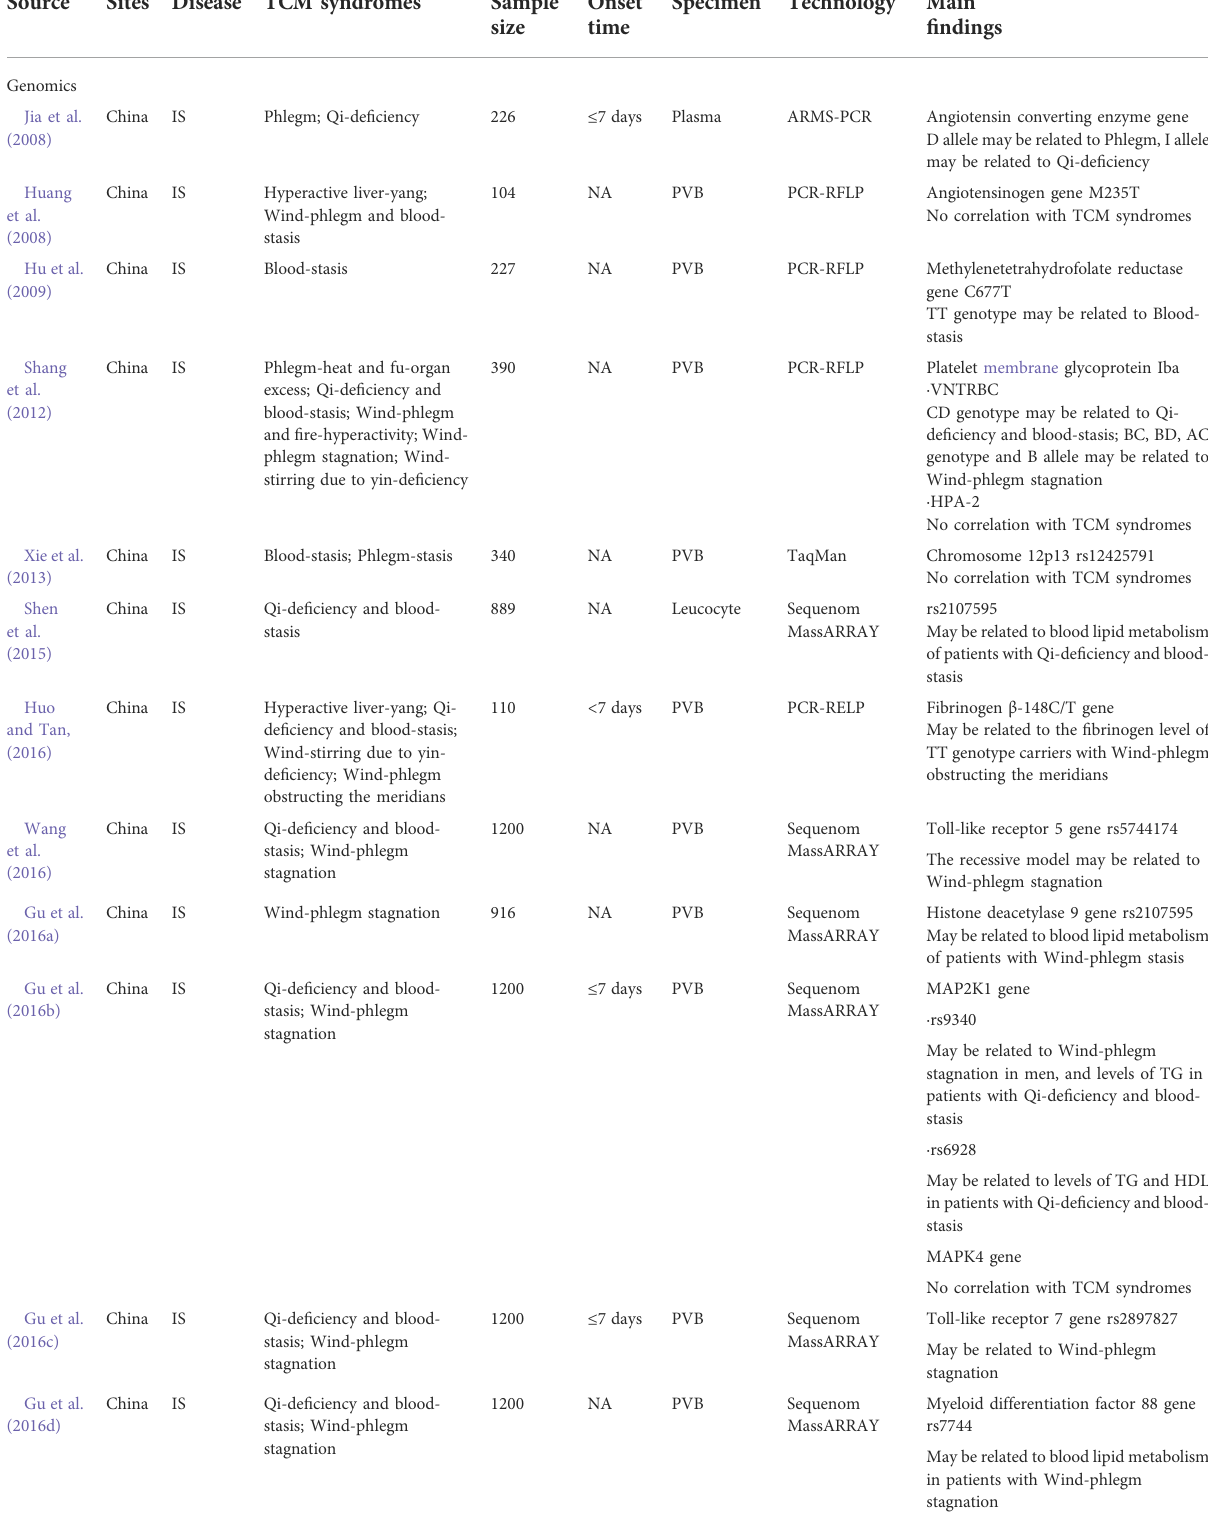
TABLE 1 Summary of the main fi ndings of the included genomics